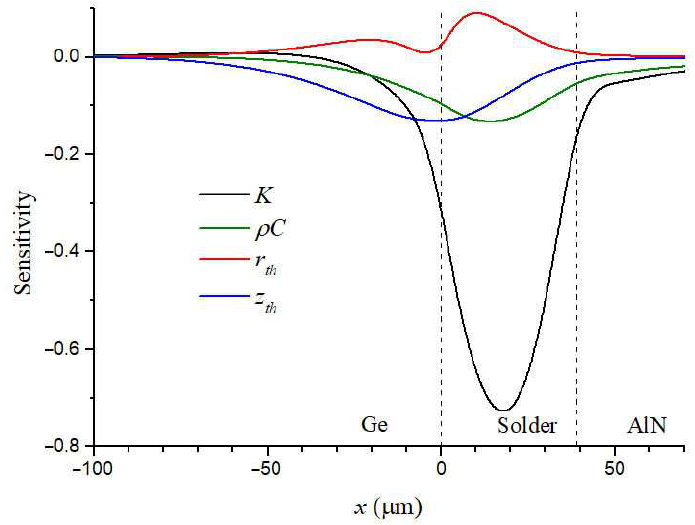
Figure 4. Calculated sensitivities to thermal conductivity, K , volumetric heat capacity, ρ C , the interfacial TR, r th , and the reactive thermal conductance, z th , for the sample in Figure 3. Dash lines are solder layer boundaries.